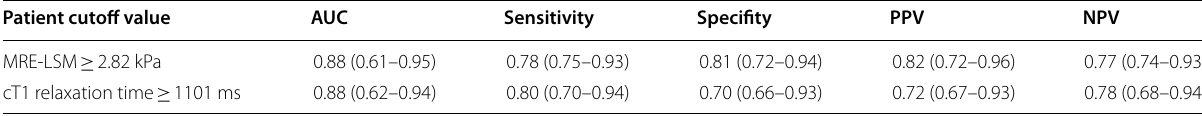
Numbers in parentheses are 95% confidence interval AUC, area under the curve; NPV, negative predictive value; PPV, positive predictive value